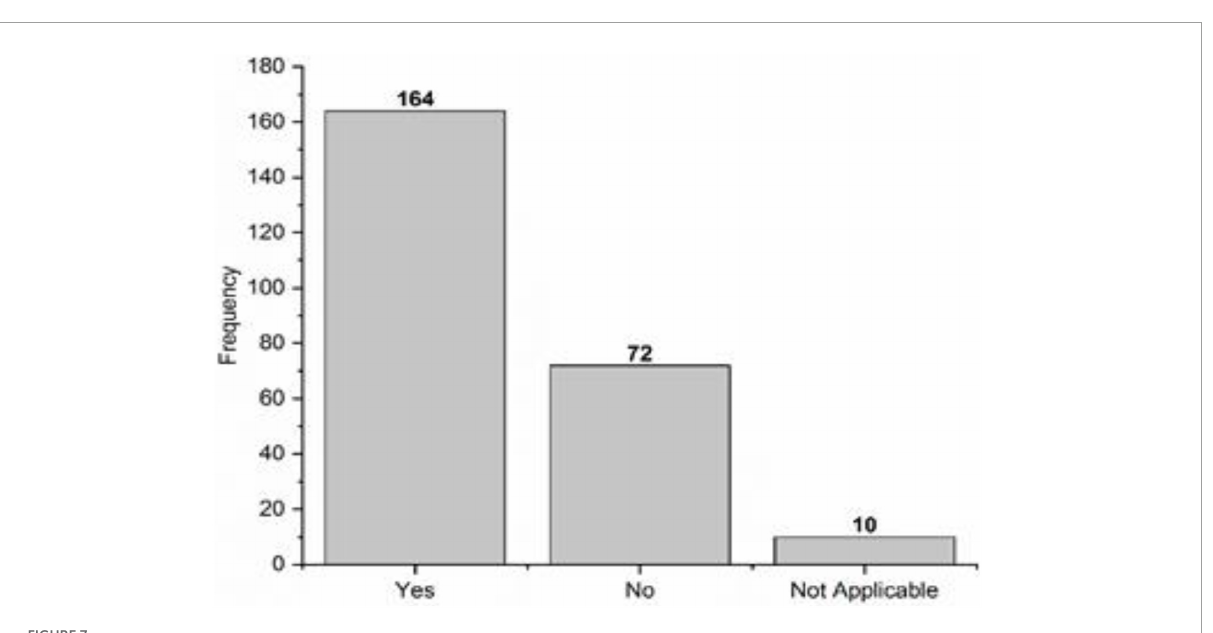
FIGURE7 Were girls permitted to use devices during school